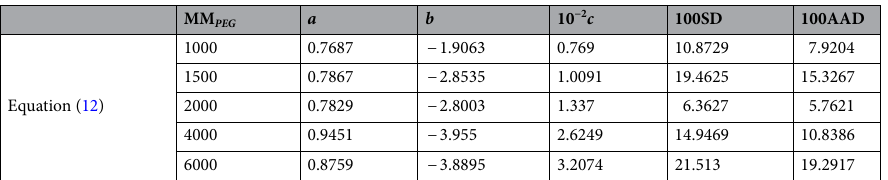
Table 4. Values of parameters of Eq. 12 for PEG 1000,1500,2000,4000,6000 (1) + trilithium citrate (2) + water (3) system at T = 298.15 K. AAD%